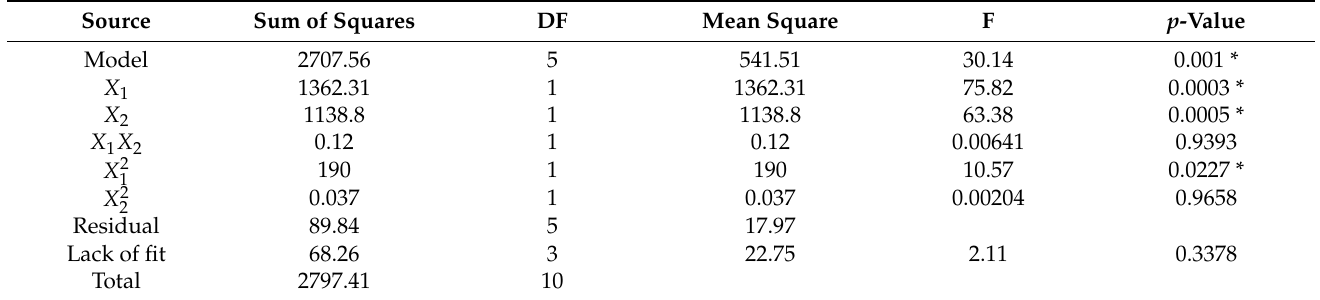
Table 2. Analysis of variance for model regression representing hydrolysis yield of textile waste.